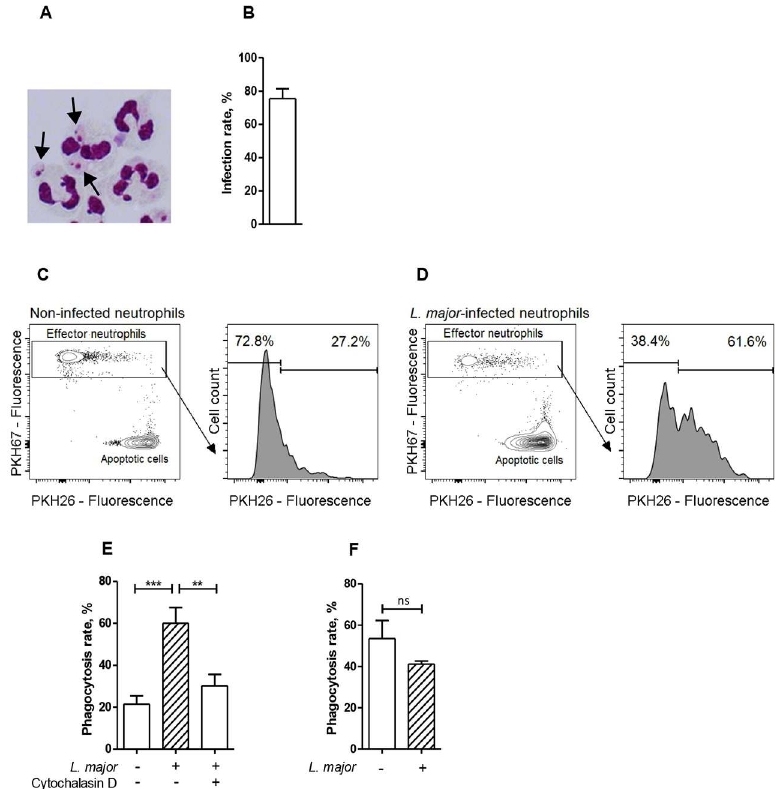
Fig 1. Infection with Leishmania major results in enhanced phagocytosis of apoptotic cells by neutrophils. (A) A micrographof Diff Quik-stained neutrophilsinfected with L . major promastigotes. Arrows indicate L . major parasites inside neutrophils. (B) Percentage of infected neutrophilsafter co-incubation with L . major for four hours. (C and D) Representative flow cytometry dot plots and histograms of (C) non-infected and (D) L . major -infected PKH-67-labeled neutrophilsco-incubated with PKH-26-labeled apoptoticcells. (E) Phagocytosis of apoptoticcells by non-infectedand L . major -infected neutrophilsin the absenceor presence of cytochalasin D. (F) Phagocytosis of latex beads by non-infectedand L . major -infected neutrophils.Data are shown as mean ± SEM of five (B, E) or three (E) independentexperiments; *** p (cid:20) 0.001, ns = not